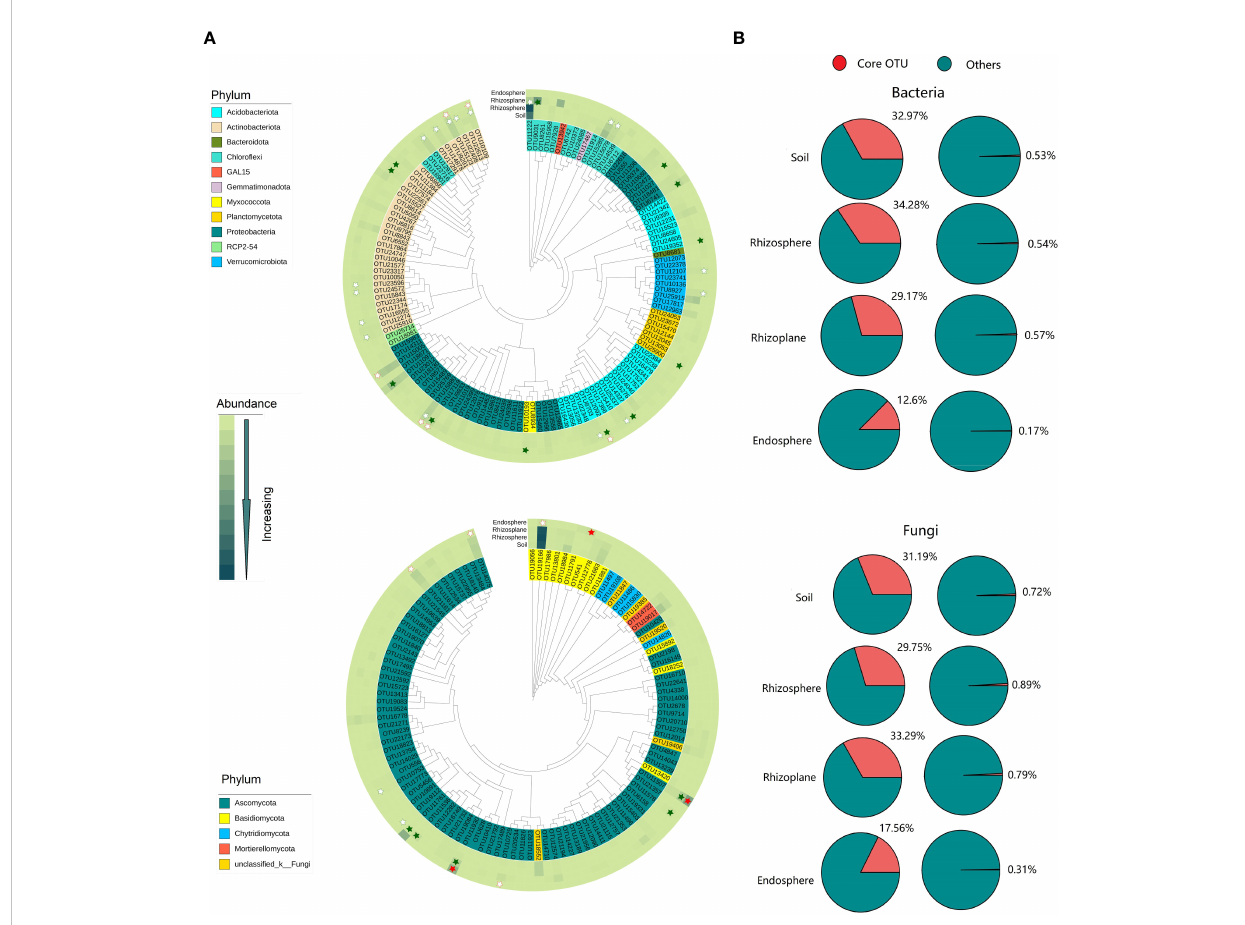
FIGURE 2 Composition and phylogenetic tree of core microbes in different compartments of the root of rubber trees. (A) : Phylogenetic tree of core bacterial and fungal communities in different compartments. Solid star represents enriched OTUs, open star represents depleted OTUs, red indicates enriched or depleted OTUs in the endosphere, and green indicates enriched or depleted OTUs in the rhizoplane. (B) : The percentage of core bacteria and fungi in abundance and OTU richness. Core bacterial OTUs: present in all samples of each compartment and with a relative abundance >0.01%. Core fungal OTUs: present in at least 60% samples of each compartment and with a relative abundance ≥